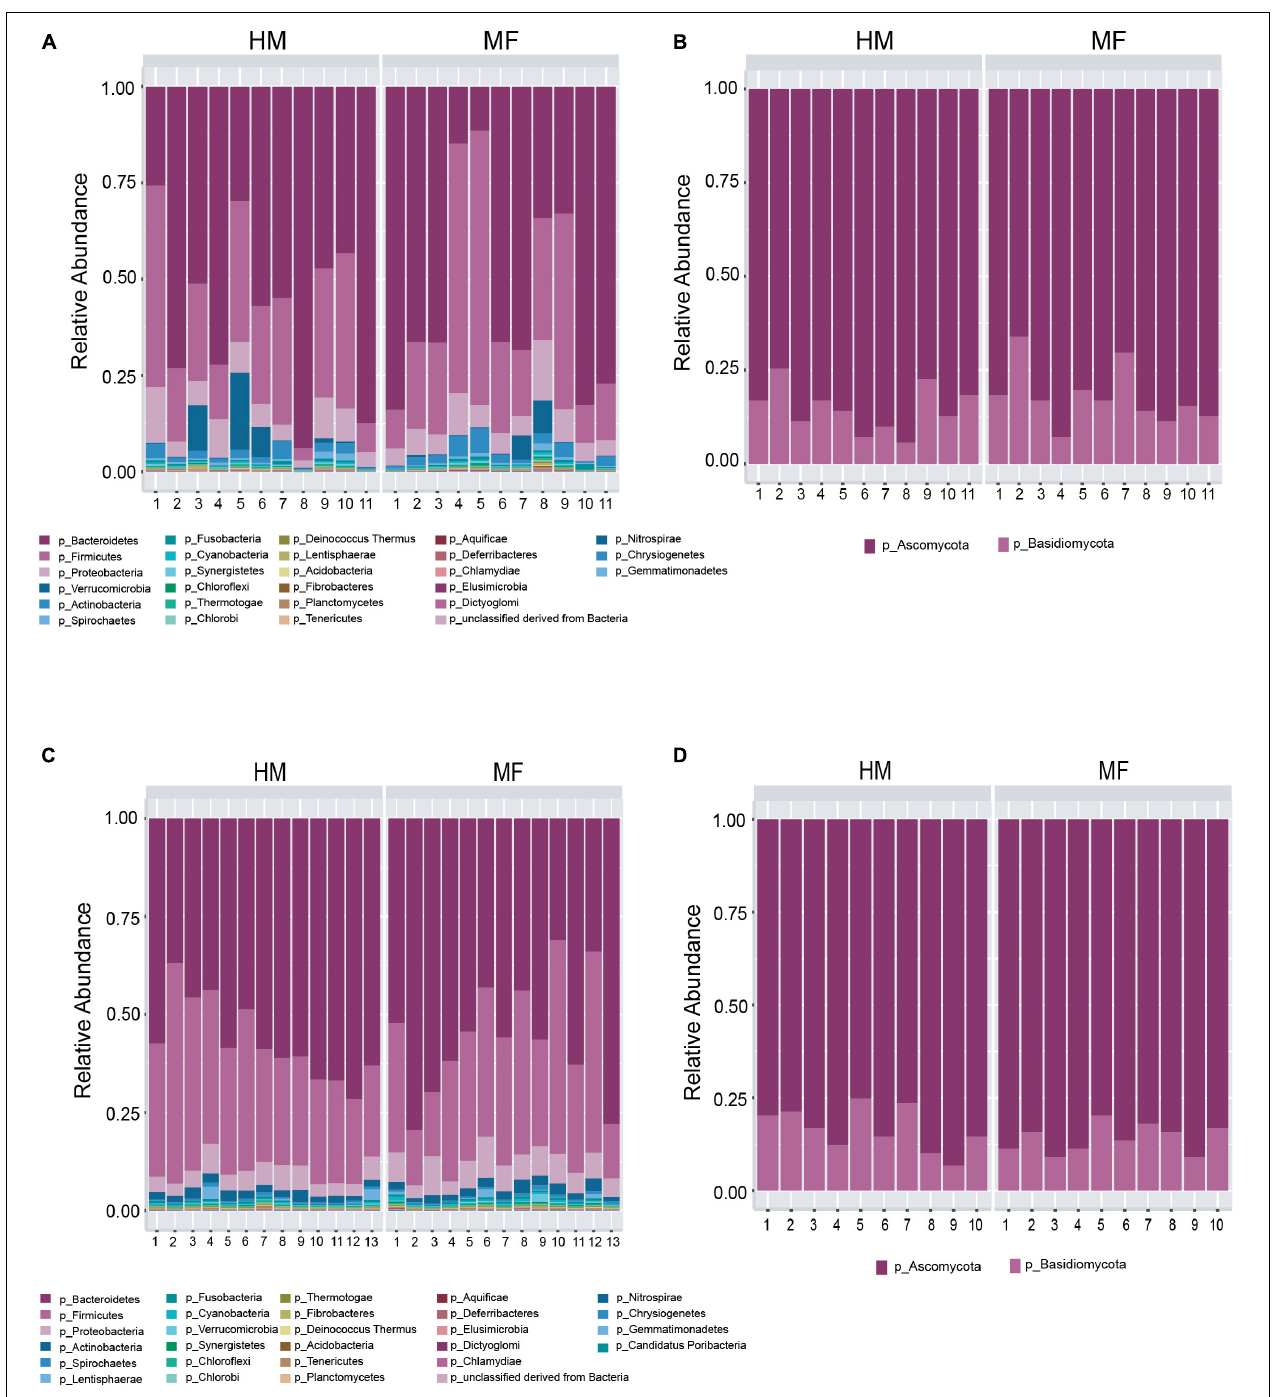
FIGURE 1 | Taxonomic composition at phyla level at postnatal day 21 (PND 21) in male piglets fed with human milk (HM) or milk formula (MF) from day 2 until day 21 of age. (A) Cecal bacteria; (B) cecal fungi; (C) distal colon bacteria; (D) distal colon fungi.